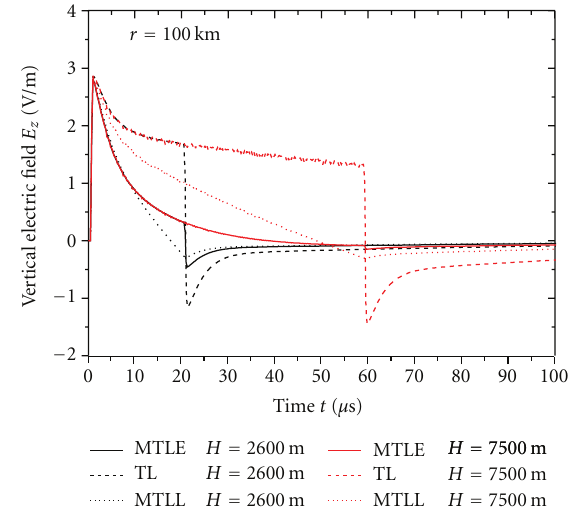
Figure 4: Vertical electric field at 50m from the channel base for NCBC, three di ff erent models and two channel heights ( H = 2600 m and 7500 m).